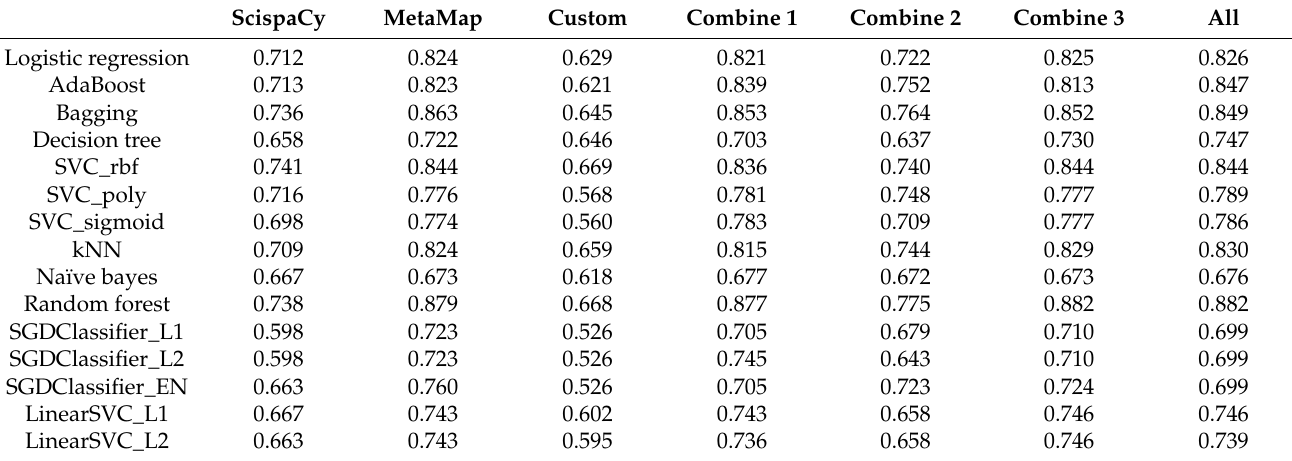
Table 4. The area under the ROC curves on the testing